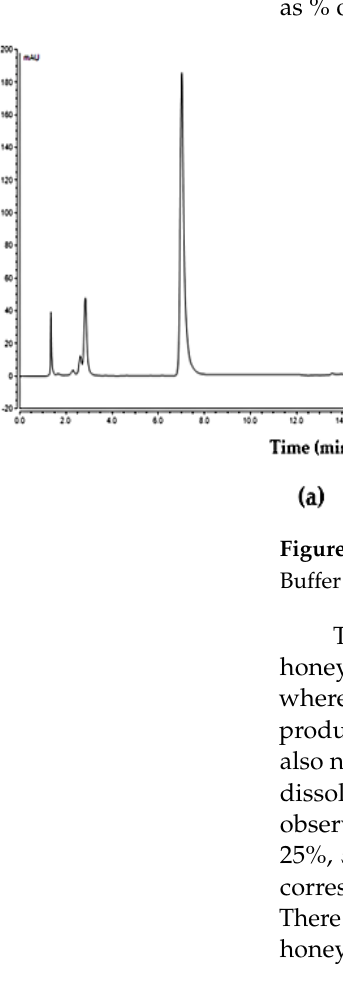
Table 1. MGO Release Data ( n = 3, data represents mean ±